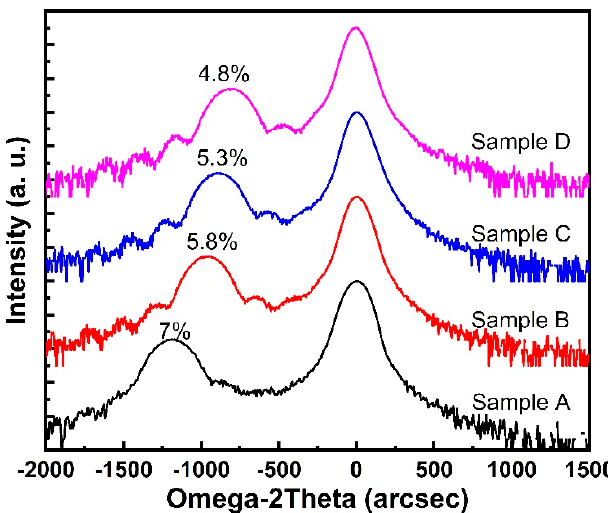
Figure 1. XRD curves of p-InGaN samples (color online).